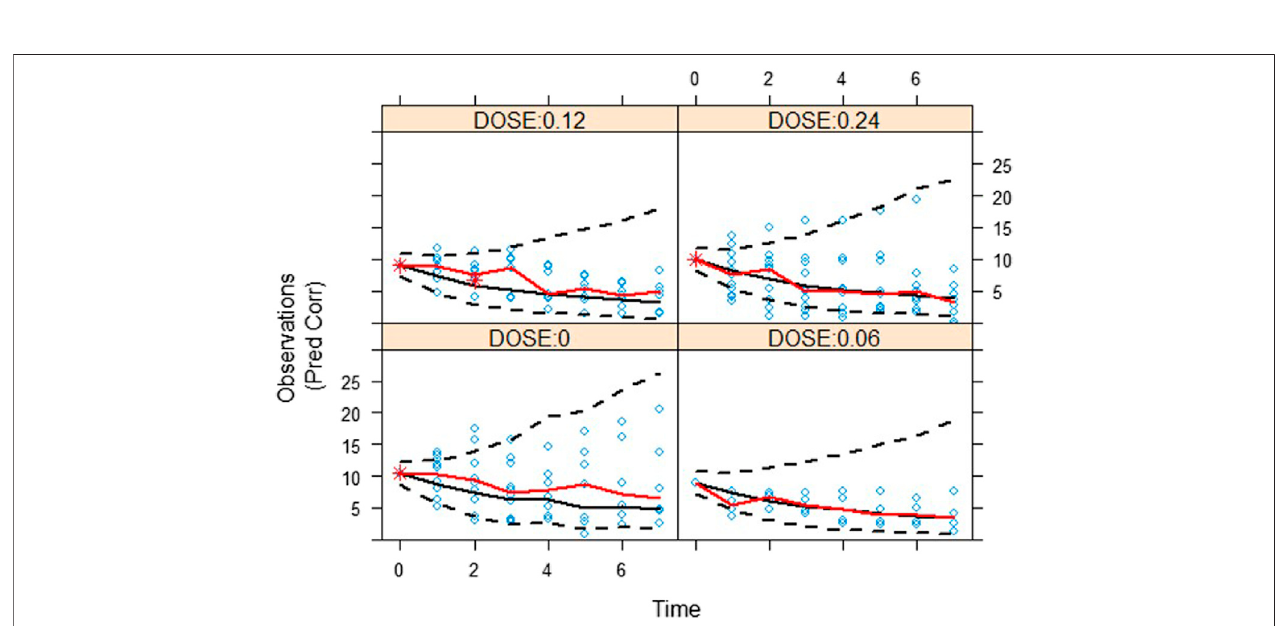
FIGURE 2 | A visual assessment of the prediction-corrected posterior predictive performance (pcVPC) of the drug effect model in terms of its ability to predict the observed SOFA score. Red solid lines are the 50th percentiles for observation. And black dash lines and black solid lines are the 10th, 50th, and 90th percentiles for